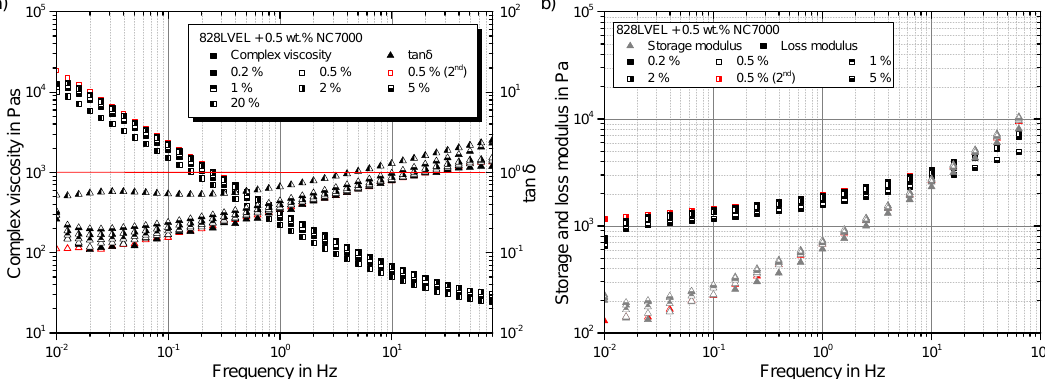
Figure 9. Frequency dependency of ( a ) complex viscosity and tan δ and ( b ) storage and loss